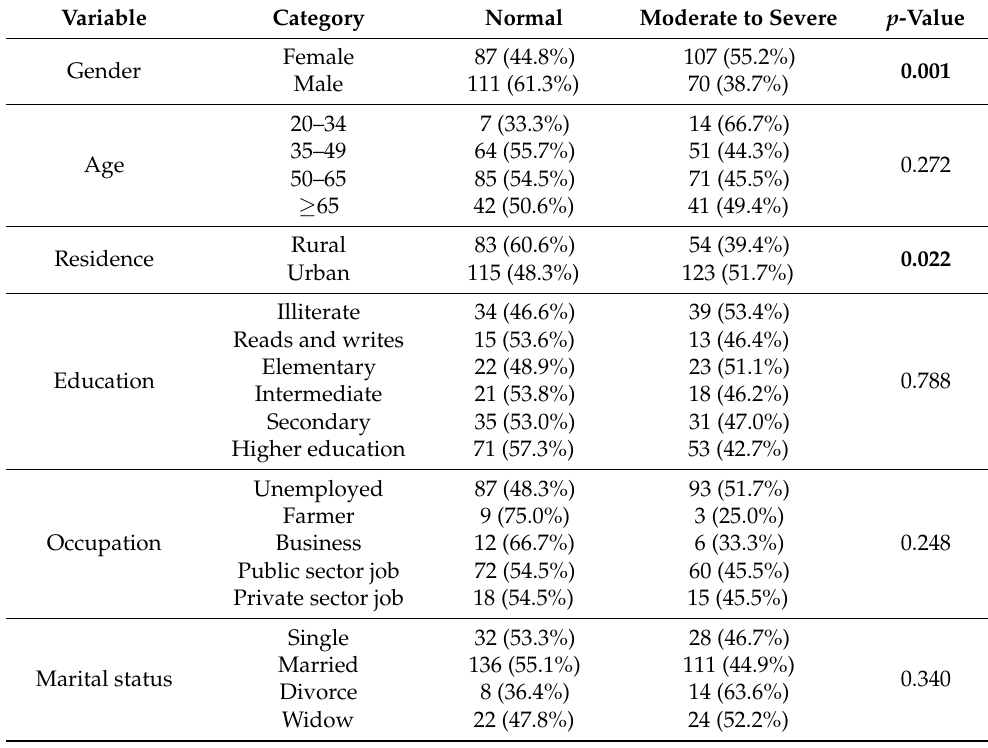
Table 3. Distribution of anxiety according to demographic characteristics of participants ( n =